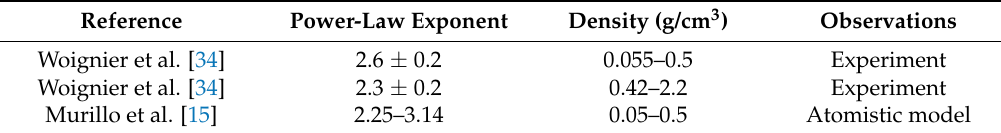
Table 2. Exponent for the power law relation between yield strength and density of porous